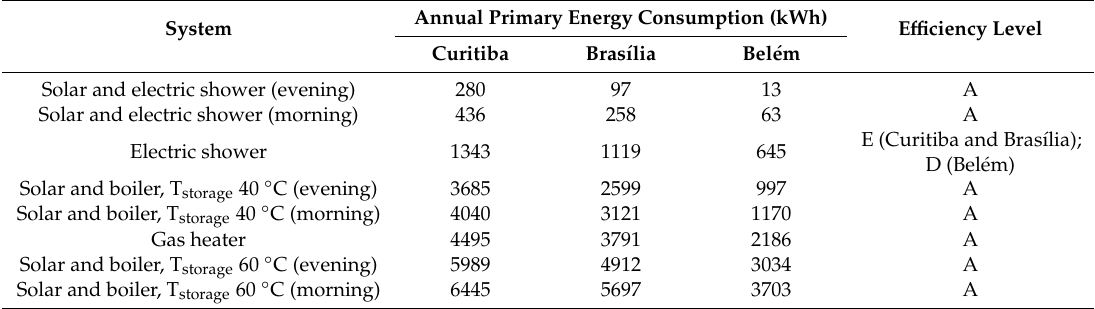
Table 7. Comparison of primary energy consumption and energy e ffi ciency according to RTQ–R.